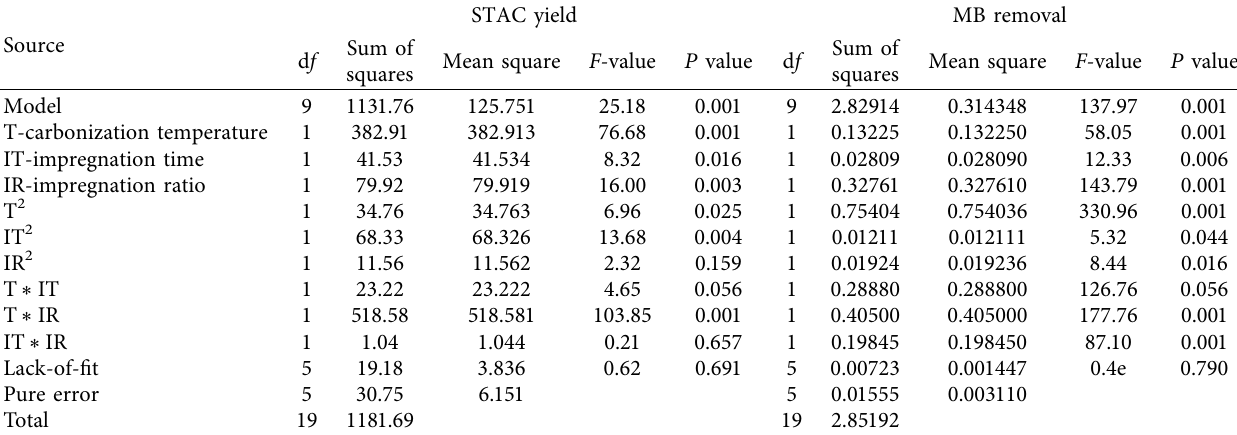
Table 4: Response surface quadratic model of ANOVA for MB